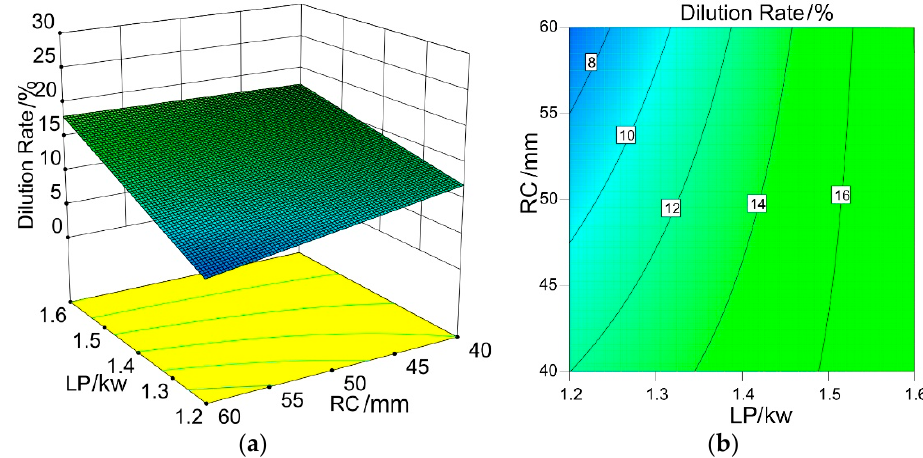
Figure 14 . ( a ) 3D response surface showing the influence of laser power and outside radius on dilution rate. ( b ) Contour line of the response surface.